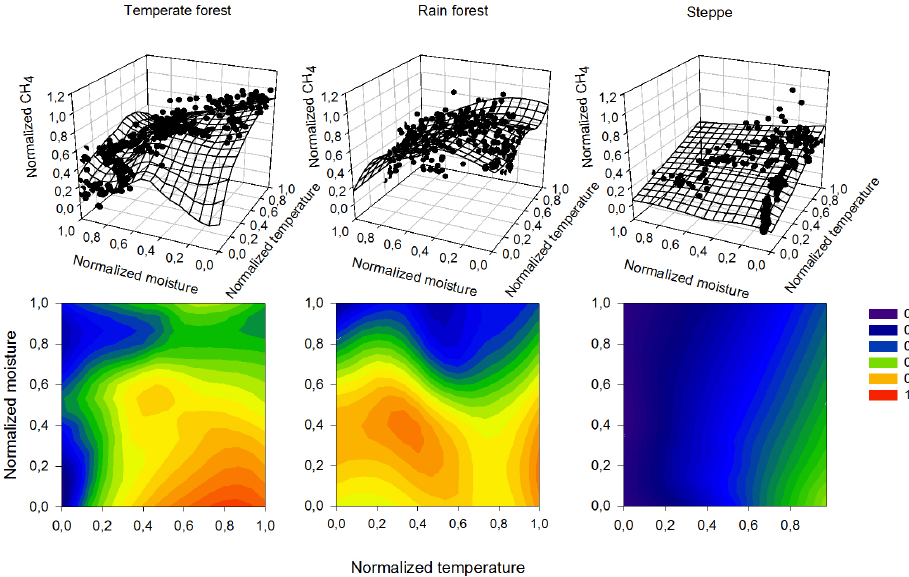
Fig. 8. Temperature and moisture effects on soil methane uptake rates for the three different ecosystems (temperate forest, semi-arid steppe, and tropical rain forest). For this analysis methane flux, soil temperature, and moisture data were normalized at site scale to a range of 0–1 (0: lowest observed value; 1: highest observed value). Prior to the calculation of contour lines, data were smoothed with the loess algorithm or negative exponential algorithm (sampling proportion